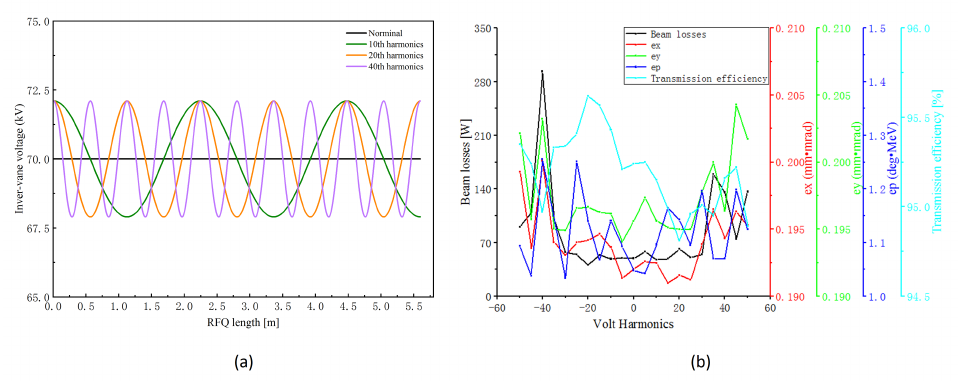
Figure 7. Inner-vane voltage harmonics error. ( a ) Inner-vane voltage harmonics, ( b ) Simulation